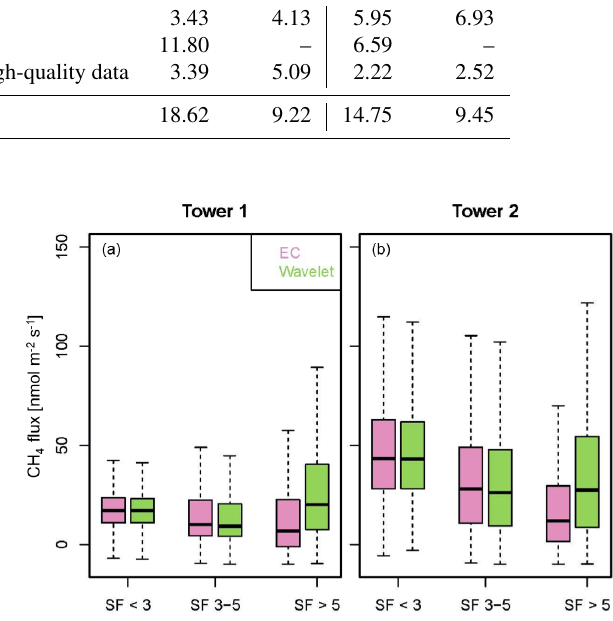
Figure 1. Median and variability of non-gap-filled methane fluxes based on the EC (pink) and wavelet (green) flux processing meth- ods for different stationarity classes at tower 1 (a) and tower 2 (b) . Black horizontal bars give the median and colored boxes indicate the interquartile range covered by the 2nd and 3rd quartile, while whiskers show the minimum and maximum flux